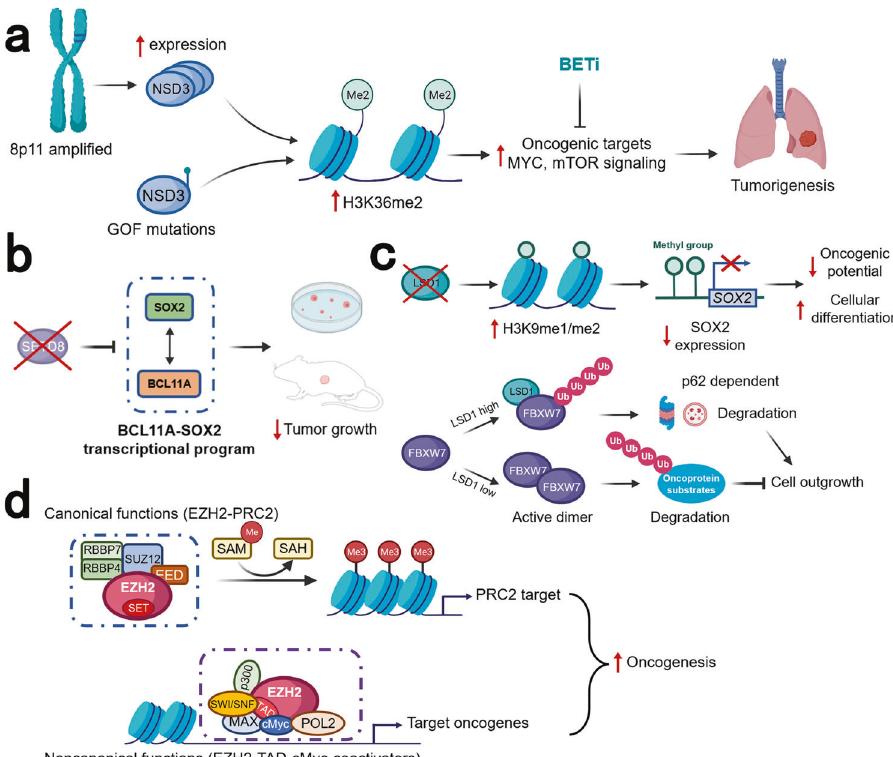
Fig. 4 Schematic diagram of the different roles for epigenetic therapeutic targets in LSCC. a A recent study suggested that NSD3 , the neighboring gene of FGFR1 , rather than FGFR1 , was the critical driver oncogene within this recurrent focal amplicon of 8p11-12 genomic region. The ampli fi cation of NSD3 leads to increased NSD3 expression, thus increasing the synthesis of H3K36me2. Less common than the ampli fi cation of 8p11-12 and NSD3 expression, the GOF variant NSD3 was also present in LSCC. These two works together to increase H3K36me2, stimulating transcription of oncogenic targets, including mTOR pathways and MYC-associated pathways. This process rendered the tumor NSD3-addicted, which could be inhibited by BETi. b SOX2 and BCL11A are both identi fi ed as LSCC oncogenes. The BCL11A-SOX2 transcriptional program is crucial for the maintenance of a squamous phenotype. SETD8 is a monomethyltransferase, whose gene is regulated by SOX2 and BCL11A. The inhibition of SETD8 selectively limits LSCC tumor growth. c LSD1 could promote tumorigenesis in two different ways. The fi rst way is demethylase-dependent. In SOX2-expressing tumor cells, LSD1 inhibition will induce increased H3K9me1/me2. The repressive H3K9 methylations act on the SOX2 gene, leading to SOX2 downregulation, reduced oncogenic potential, and increased cellular differentiation. The second way is demethylase-independent. In cells with a low level of LSD1, FBXW7 forms a dimer, which promotes ubiquitylation for proteasomal degradation of oncoprotein substrates, thus suppressing cell outgrowth. In cancer cells with overexpressed LSD1, the FBXW7 dimerization is blocked by LSD1 binding to FBXW7 in a demethylase-independent manner. FBXW7 self-ubiquitylation will then be triggered, followed by degradation by proteasome as well as lysosome in a p62-dependent pathway. d EZH2 is an enzymatic subunit of PRC2, which also includes EED, SUZ12, and RBBP4/7. The SET domain of EZH2 is responsible for the catalyzes the mono-, di-, and trimethylation of H3K27 from the universal methyl donor SAM, after which SAM becomes SAH. EZH2 also has noncanonical functions with its hidden TAD. The EZH2 TAD directly interacts with cMyc and other activators, including p300 and SWI/SNF. GOF gain-of-function, PRC2 polycomb repressive complex 2, SAH S-adenosyl- L -homocysteine, SAM S-adenosyl- L -methionine, TAD transactivation